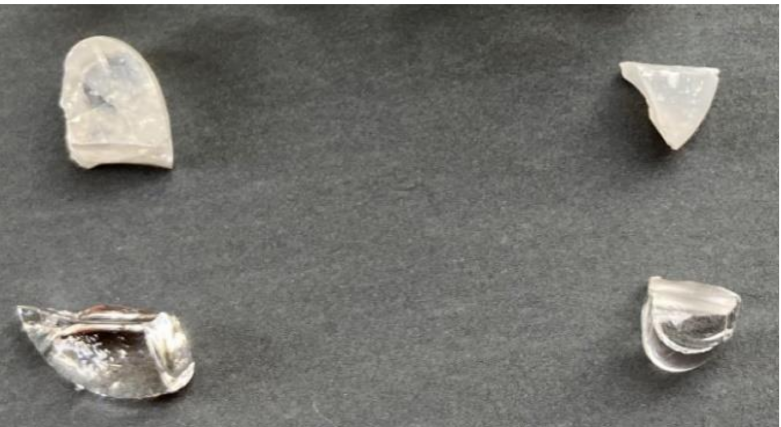
Figure 1. Photo-image of (100 − x ) (33CaO-67B 2 O 3 ) − x Ca 3 WO 6 ( x = 4 (Left) and 8 (Right)) glass before (Downward) and after (Upward) heat-treatment.